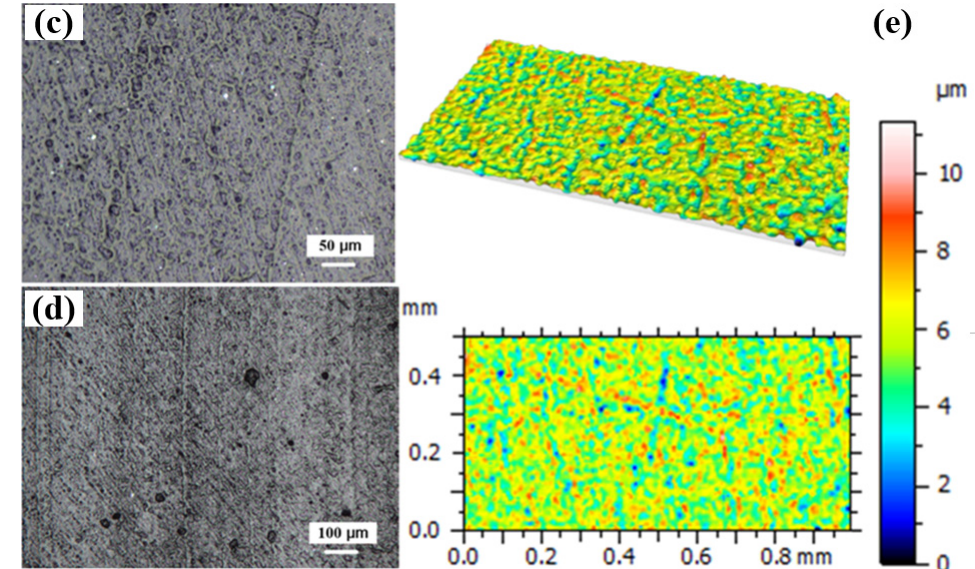
Figure 7. ( a , b ) The OM morphology of the 316L sample after friction with lubrication pressure of 12 MPa; ( c – e ) the OM images and 3D morphology of worn PTFE after friction with lubrication pressure of 12 MPa.